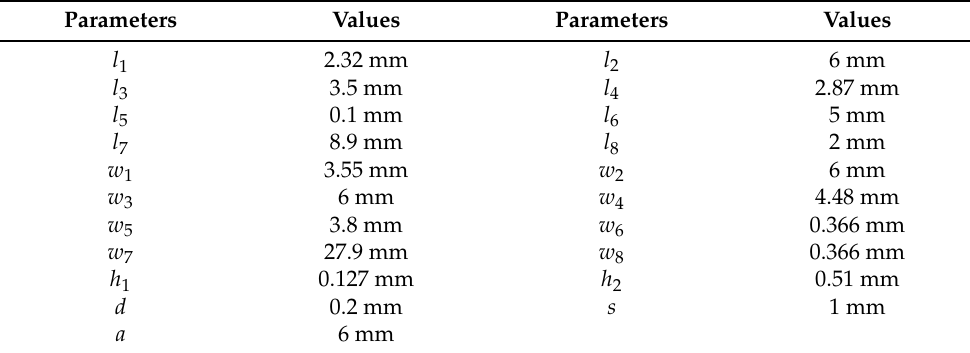
Table 1. Design parameters and their values of the proposed antenna.